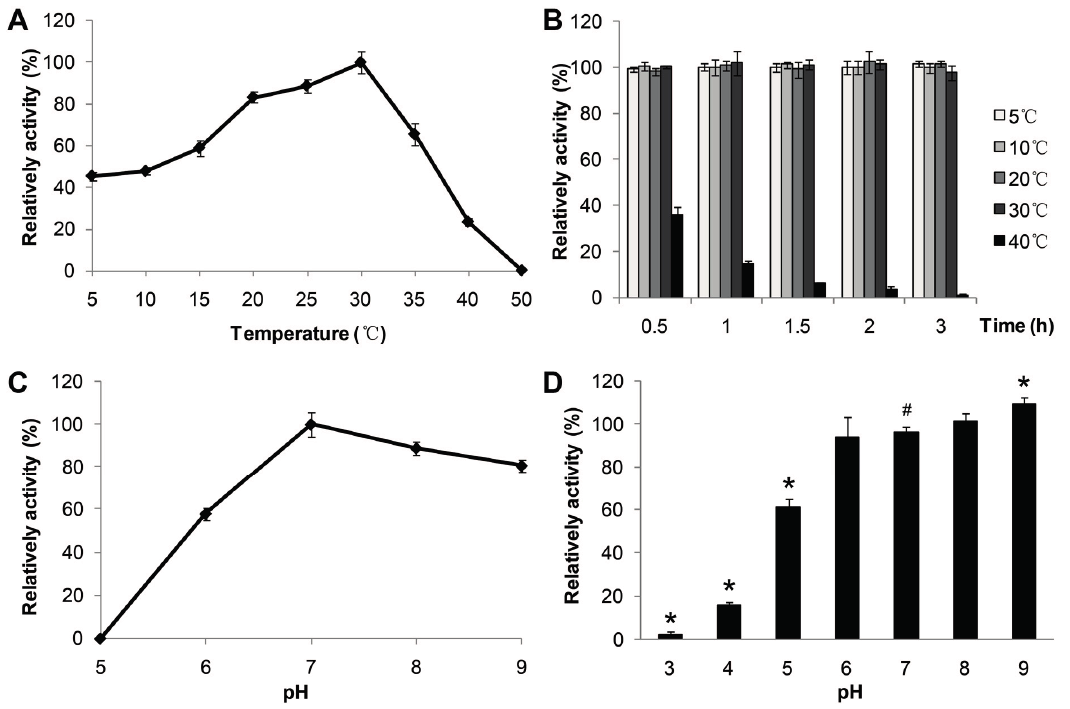
Figure 3. Effects of temperature and pH on the enzyme activity of MAJ1. ( A ) The enzyme activity was measured at various temperatures at pH 7.0. The value obtained at 30 °C was taken as 100%; ( B ) The enzyme activity was determined at 30 °C by using p -nitrophenyl caprate (C10) after treated with 2 h at different temperatures. The value obtained at 30 °C was taken as 100%; ( C ) The enzyme activity was measured at various pH. The value obtained at pH 7.0 was taken as 100%; and ( D ) The enzyme activity was determined at 30 °C by using p -nitrophenyl caprate (C10) after treated with 12 h at various pH. The value obtained at pH 7.0 was taken as 100%. # compared to the value at pH 7.0, p < 0.05; * compared to the value at pH 7.0, p <